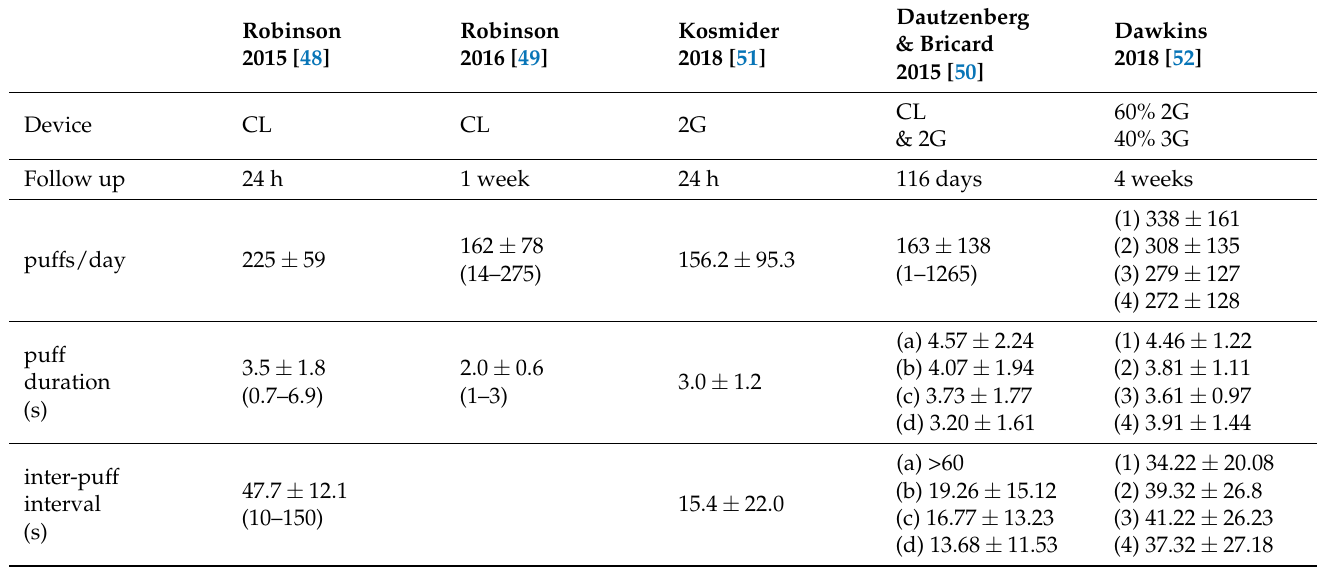
Table 1. Puffing topography under natural conditions. The table displays the main puffing parameters in 5 studies on vapers in natural conditions for extended periods. Numbers are averages with the symbol ± denoting standard deviation, the letters CL, 2G, 3G stand for closed, second generation (cartomizer) and third generation (tank) devices. In Dautzenberg and Bricard the symbols denote: single isolated puff (a), 2–5 clustered puffs (b), 5–15 clustered puffs (c) and more than 15 clustered puffs (d). In Dawkins et al.: low nicotine level fixed power (1), low nicotine level variable power (2), high nicotine level fixed power (3), high nicotine level variable power (4), with 6 mg/mL and 18 mg/mL for low and high nicotine level. Notice that puff numbers and e-liquid consumption increase with devices operating at fixed power and with low nicotine